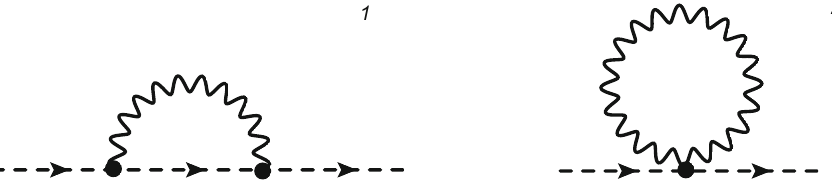
Fig. 5 One-loop Feynman diagrams contributing to the two point Green’s function (cid:7) λ α 1 ( q 1 ) ¯ λ α 2 ( q 2 ) (cid:5) . A wavy (dashed) line represents gluons (gluinos). Only the first diagram appears in